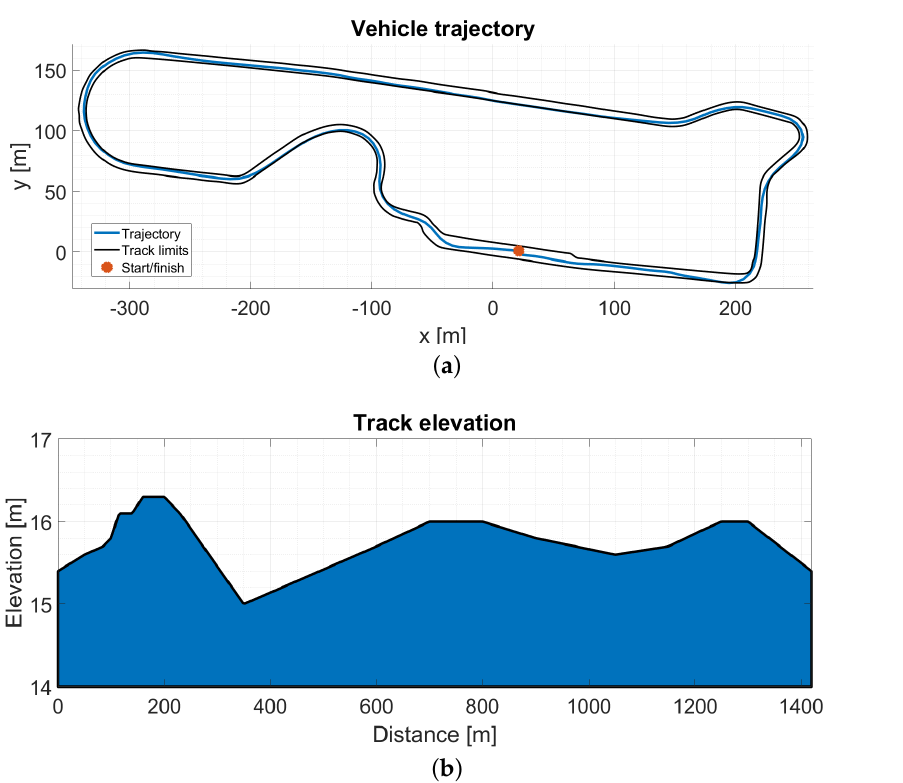
Figure 6. Track route employed for model validation. ( a ) Vehicle trajectory. ( b ) Track elevation.